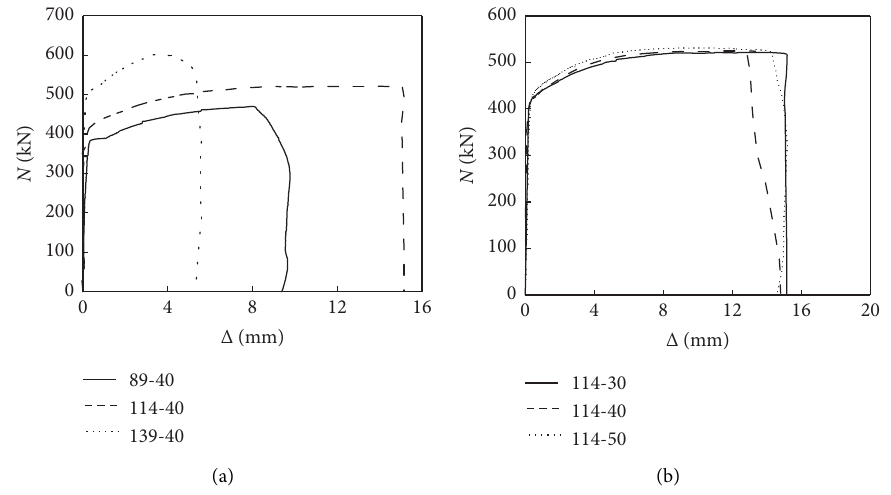
Figure 11: Load-relative displacement curve: (a) diferent outer diameter and (b) diferent concrete